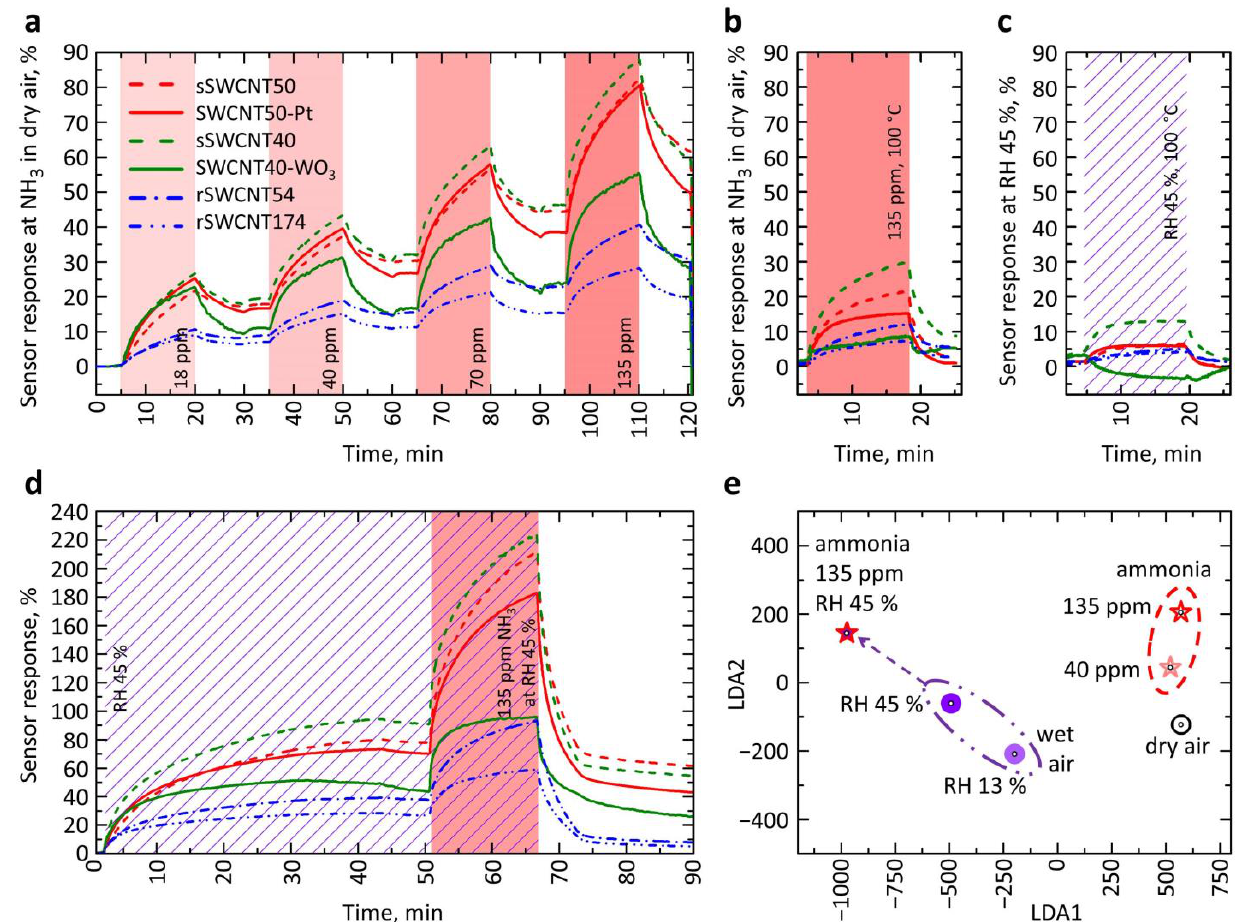
Figure 6. Sensor responses of SWCNT-based structures under study to NH 3 : ( a ) dry air background, RT; ( b ) dry air background, 100 °C; ( c ) wet air, RH = 45%, 100 °C; ( d ) NH 3 at wet air background, RH = 45%, RT; ( e ) LDA processing of the vector signal from the multisensor array composed of the four sensor structures: SWCNT50-Pt, SWCNT40-WO 3 , their satellite samples of sSWCNT50, and sSWCNT40; the 2D cross-section related to two primary components of 5D LDA space is shown, points represent the vector signals.